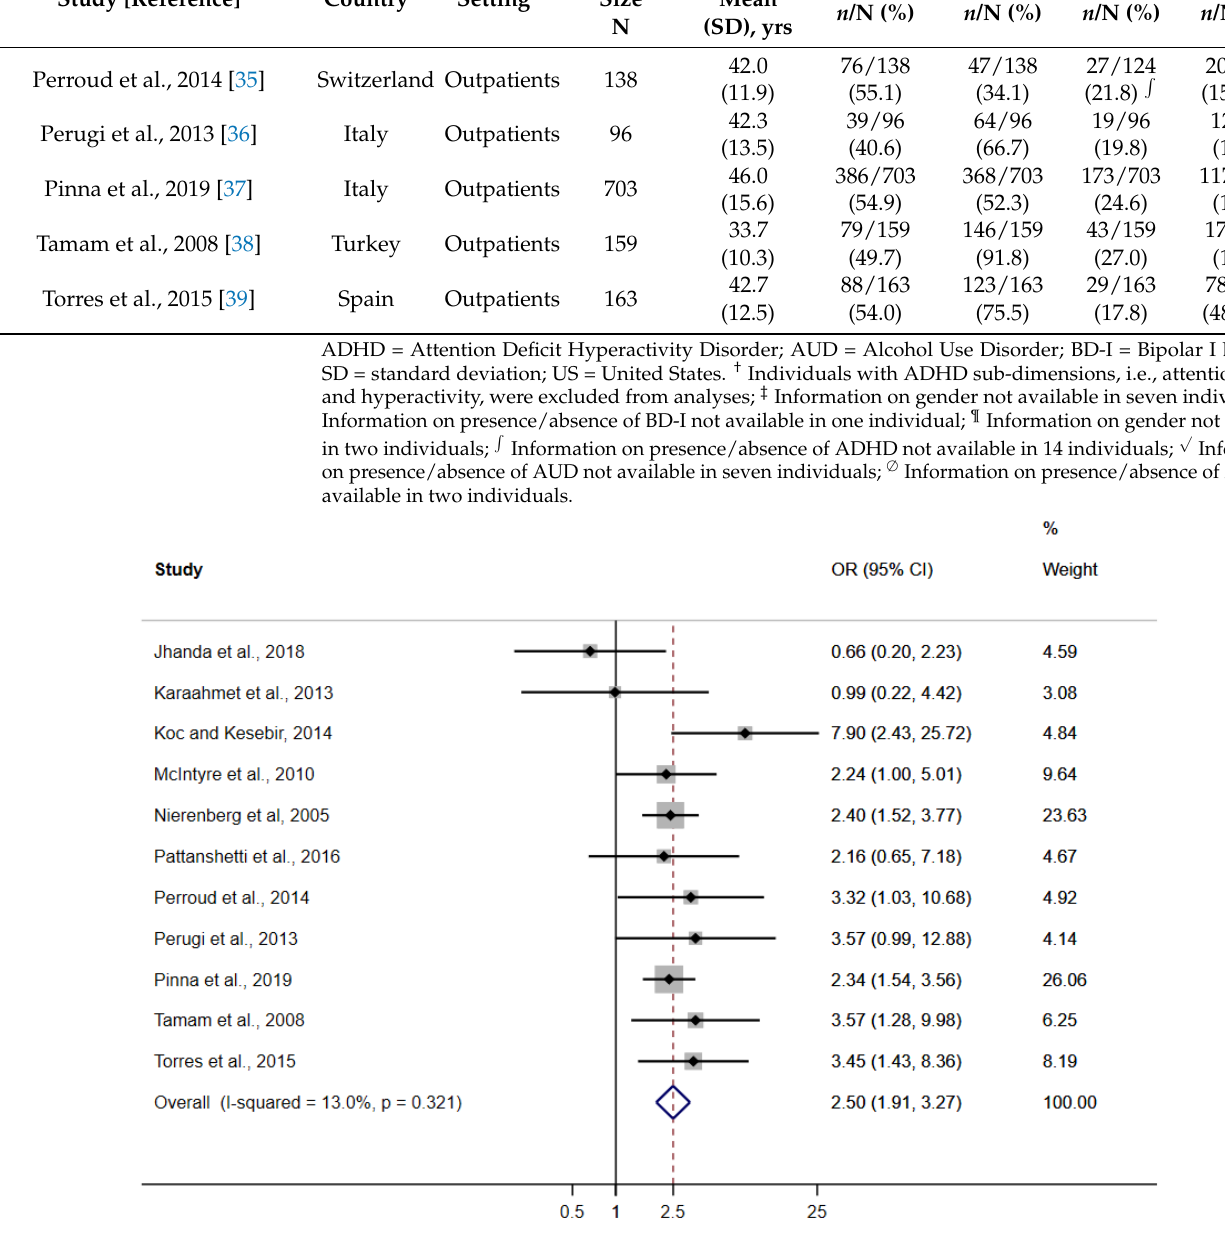
Figure 2. Association between ADHD and Alcohol Use Disorder in Bipolar Disorder. Table 2. Influence on effect size of study-level characteristics: meta-regression